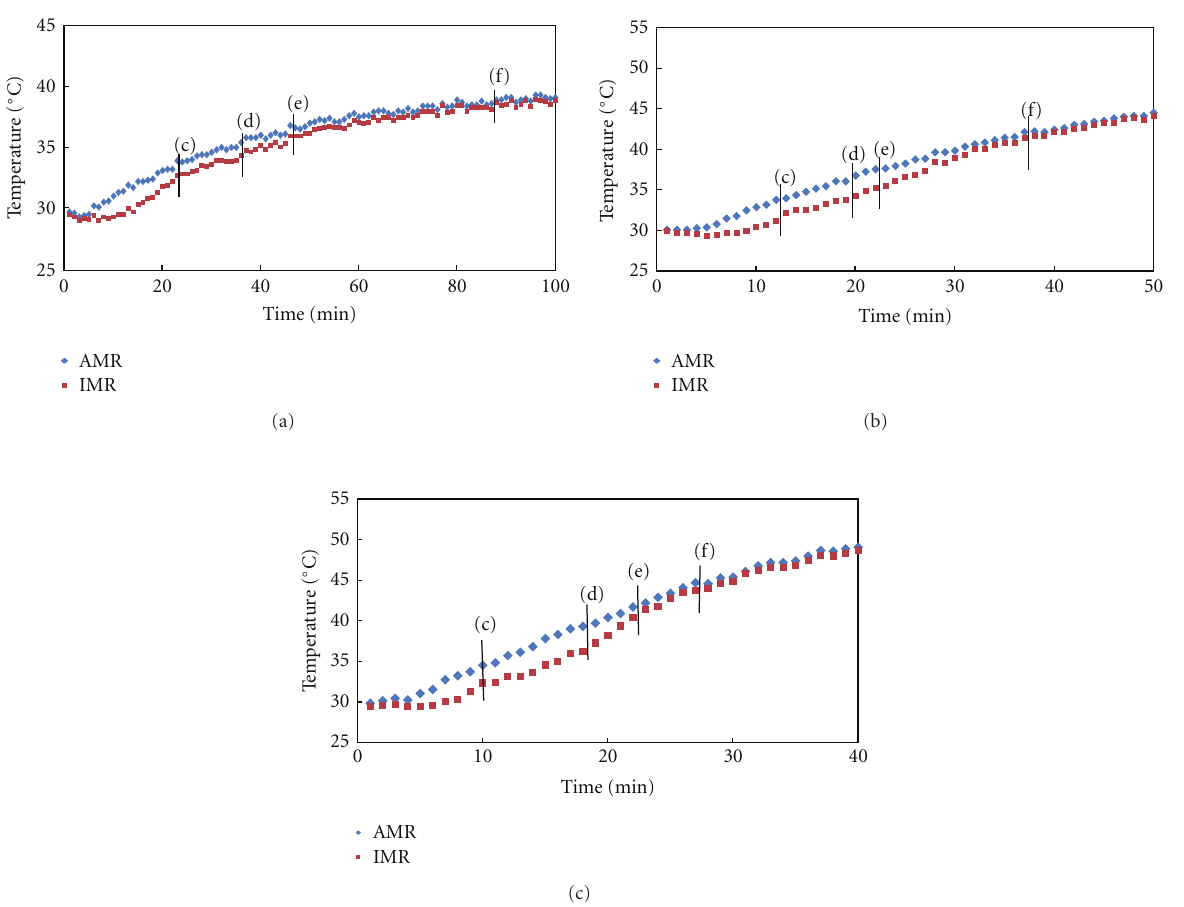
Figure 5: Time variation of temperature in the upper IMR and AMR: (a) Δ T = 10K, (b) Δ T = 20K, and (c) Δ T = 30K.